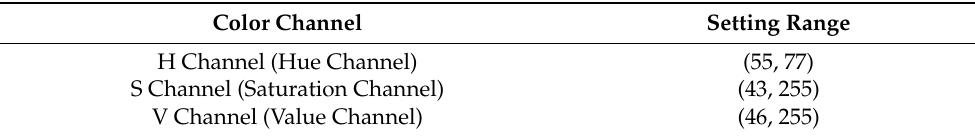
Table 5. The setting range of the three HSV